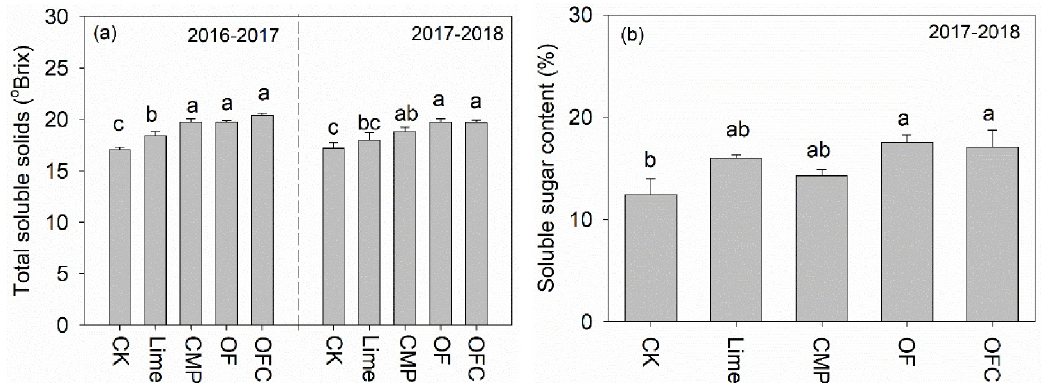
Fig 4. (a) Total soluble solids and (b) soluble sugar content of banana fruits in different years. The plants were grown in soil amended with lime (Lime), calcium magnesium phosphate fertilizer (CMP), organic fertilizer (OF), organic fertilizer with calcium magnesium phosphate fertilizer (OFC) or remained unamended (control, CK). Values are means ± SE (n = 3). Different lowercase letters above the bars denote significant differences among treatments in 2016–2017 and 2017–2018 ( P <